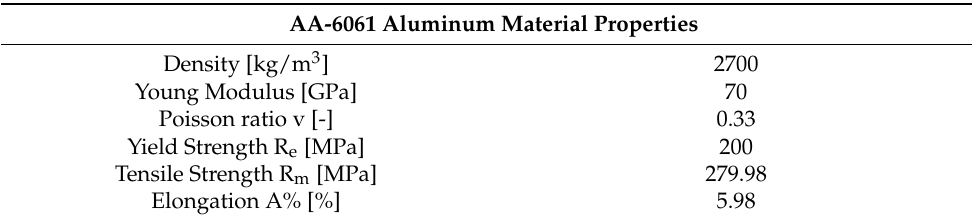
Table 1. Materials properties of the aluminum columns Data from Ref. [26].